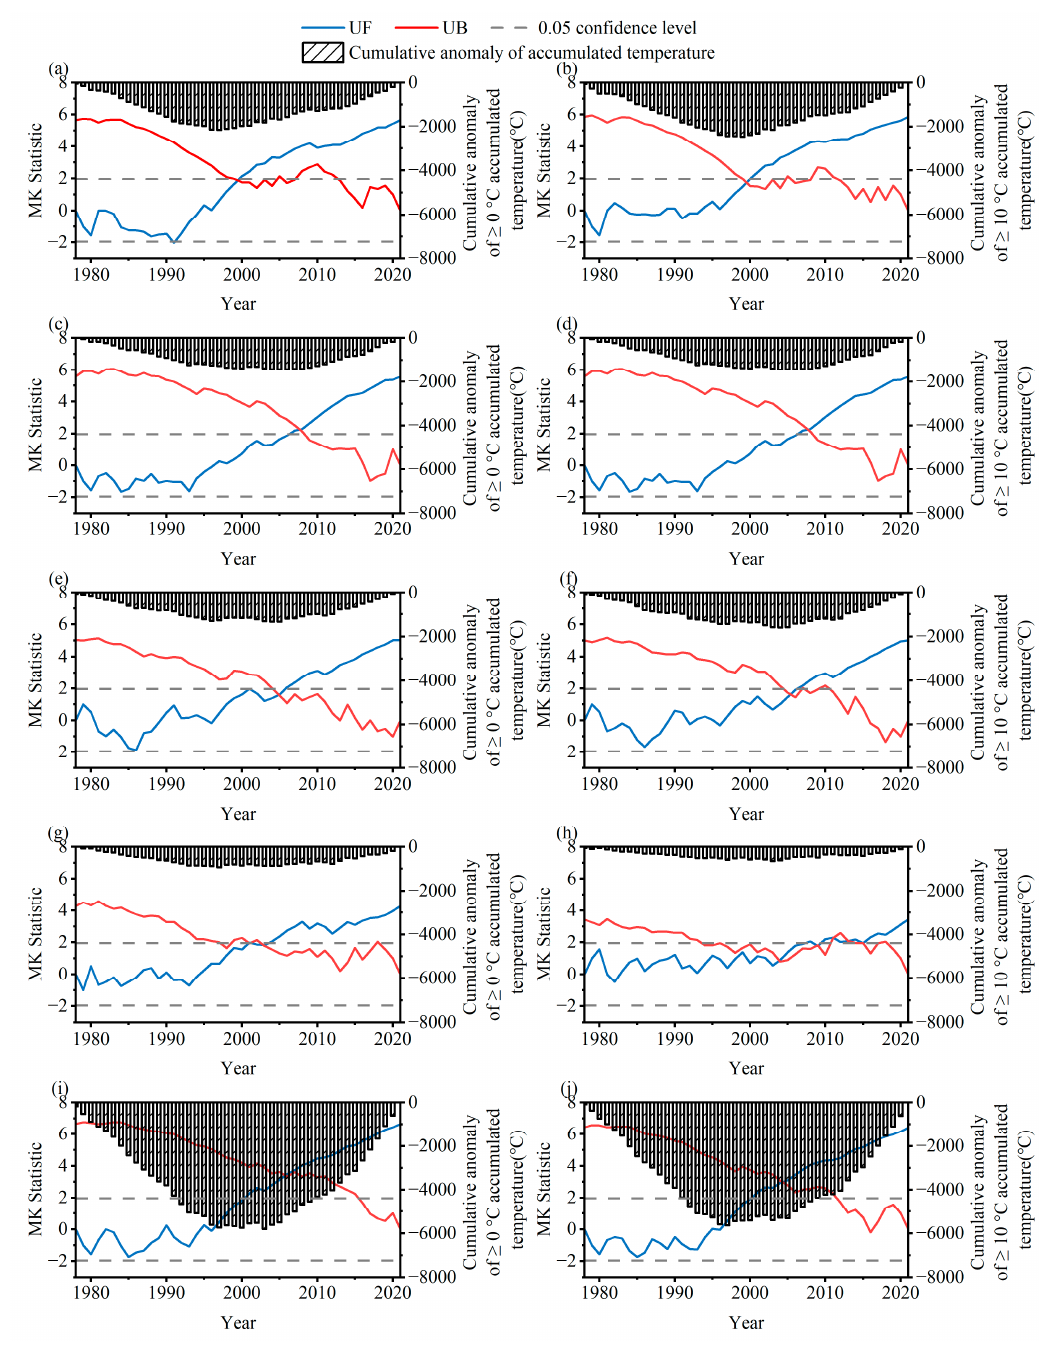
Figure 2. The sudden change characteristics of accumulated temperature in Henan Province from 1978–2021 under different time scales. ( a – h ) represent the seasonal scale, where ( a , b ) represent spring, ( c , d ) represent summer, ( e , f ) represent autumn, and ( g , h ) represent winter. ( i , j ) represent the annual scale.